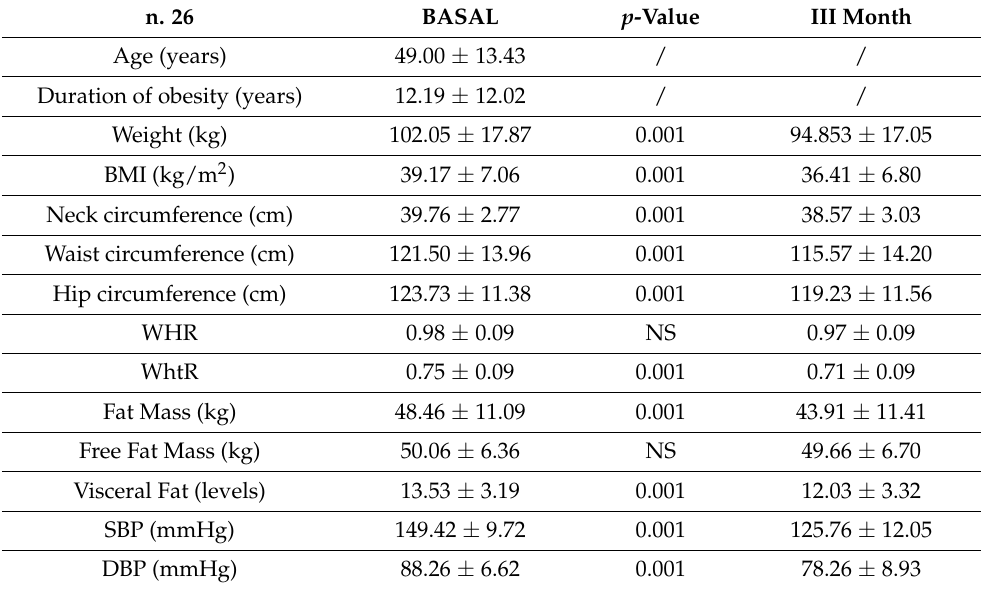
Table 1. Clinical characteristics before and after life style modifications (Mean ± Standard Deviation).